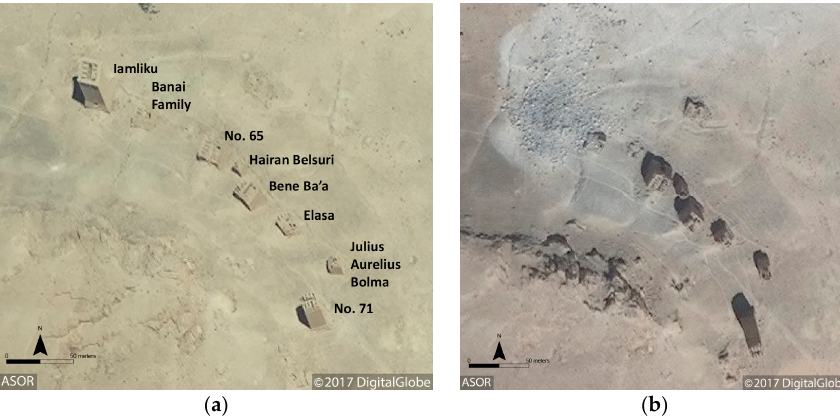
Figure 7. DigitalGlobe satellite imagery of the Valley of the Tombs: ( a ) with no visible damage (DigitalGlobe NextView License; 26 June 2015); ( b ) with visible damage to Tomb of Iamliku and Tomb of the Banai Family (DigitalGlobe NextView License; 27 August 2015).